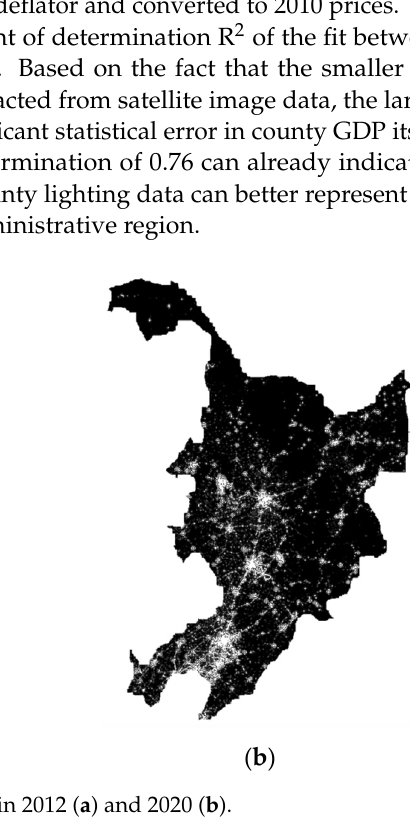
Figure 2. The fitting diagram of county GDP and county SOL in Northeast China from 2012 to 2020. 2.3. Energy Statistics Sources Energy consumption data for Northeast China were obtained from the energy balance sheets of each region in the China Energy Statistical Yearbook (2013–2020); the average low calorific value NCV of various energy sources was obtained from the China Energy Statistical Yearbook 2017 ; the CO 2 emission factor CEF of different energy sources was obtained from the 2006 National Greenhouse Gas Emissions Inventory Guide . The GDP of some counties and cities in Northeast China and the GDP index data of each province are from the China Statistical Yearbook (2013–2020). 3. Research Methodology 3.1. Calculation of Carbon Emissions from Energy Consumption